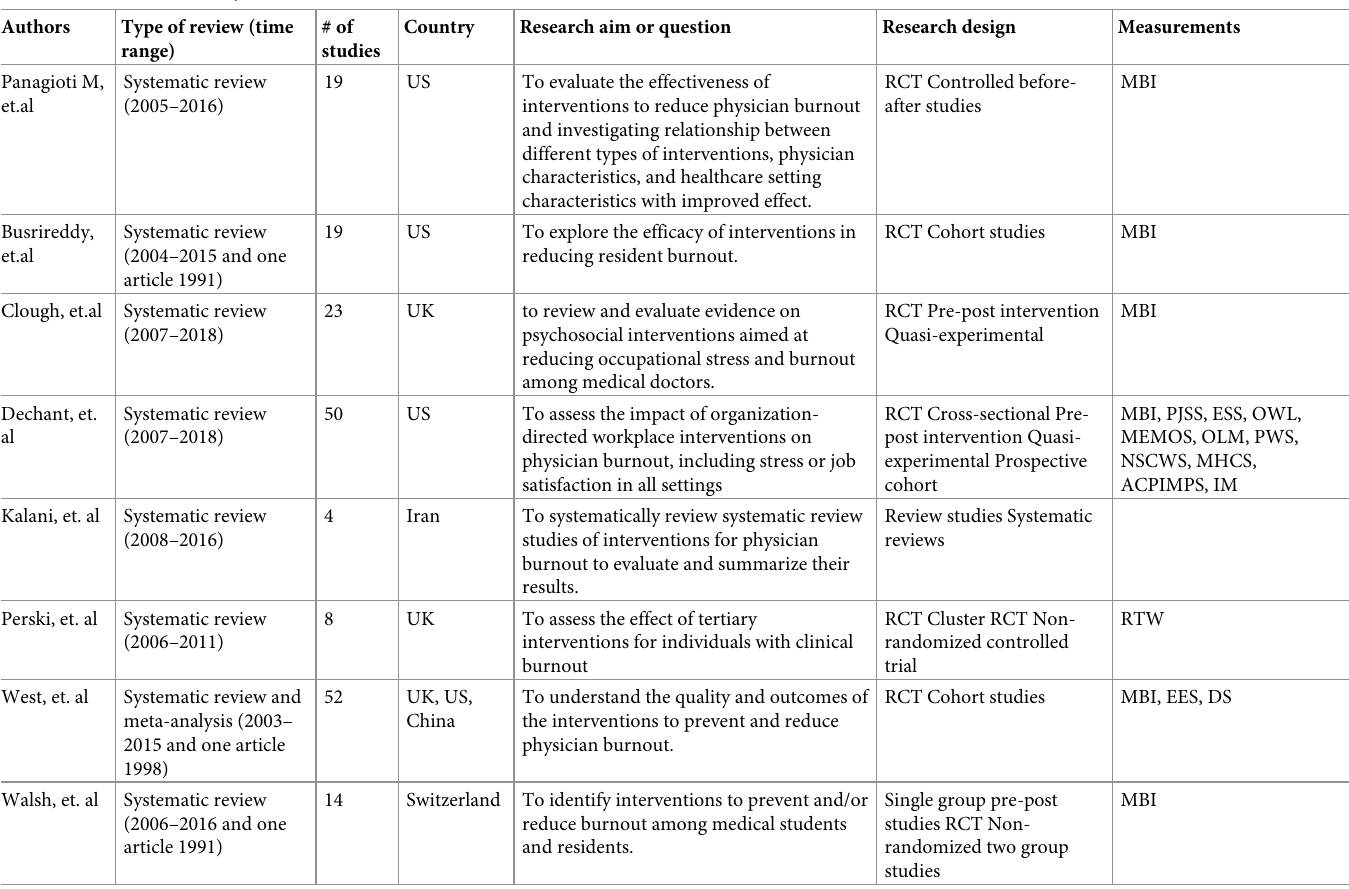
Table 1. Characteristics of systematic